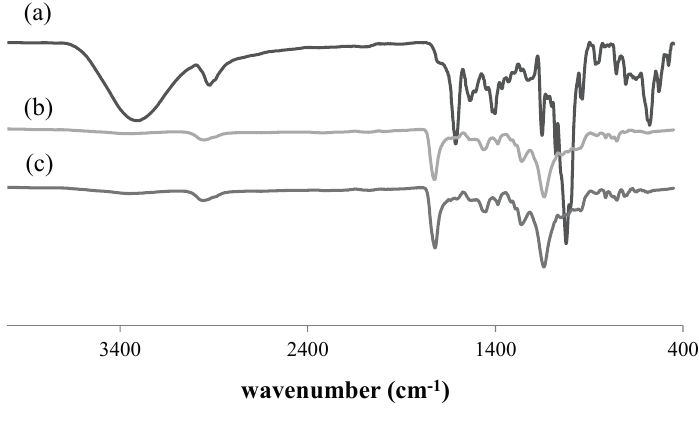
Figure 4. FTIR spectra of ( a ) MAA- β -CD; ( b ) RAFT-MIP1; and ( c )